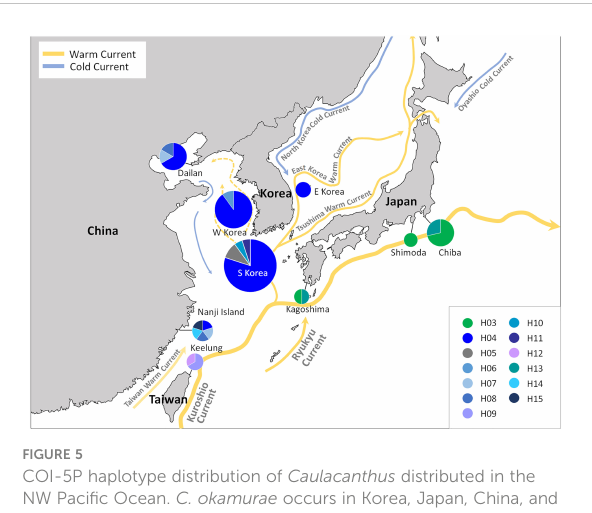
FIGURE 5 COI-5P haplotype distribution of Caulacanthus distributed in the NW Paci fi c Ocean. C. okamurae occurs in Korea, Japan, China, and Taiwan, and Lineage 3 is distributed only in Shimen and Okinawa in this region. Each pie chart represents the proportion of the haplotype presented within the site.